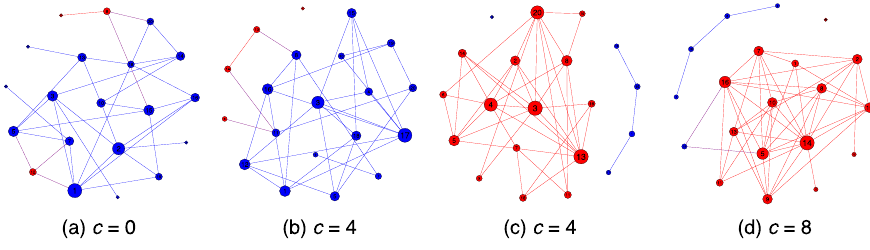
Figure 5. This figure displays the final state of four networks. Blue stands for cooperation and red for defection. The size of each node represents the number of neighbors of a node. The figure shows that the cost of obtaining information dramatically alters the final state of the network. The free information treatment results in a majority of cooperators playing each other in a densely connected social network (a). The high- cost treatment results in a majority of defectors, again fairly densely connected (d). The low-cost treatment produces a case that is similar to the low- cost treatment (compare (b) to (a)) or a state that is similar to the high cost treatment (compare (c) to (d)). Cooperation in dynamic social networks exhibits path dependence in the low-cost